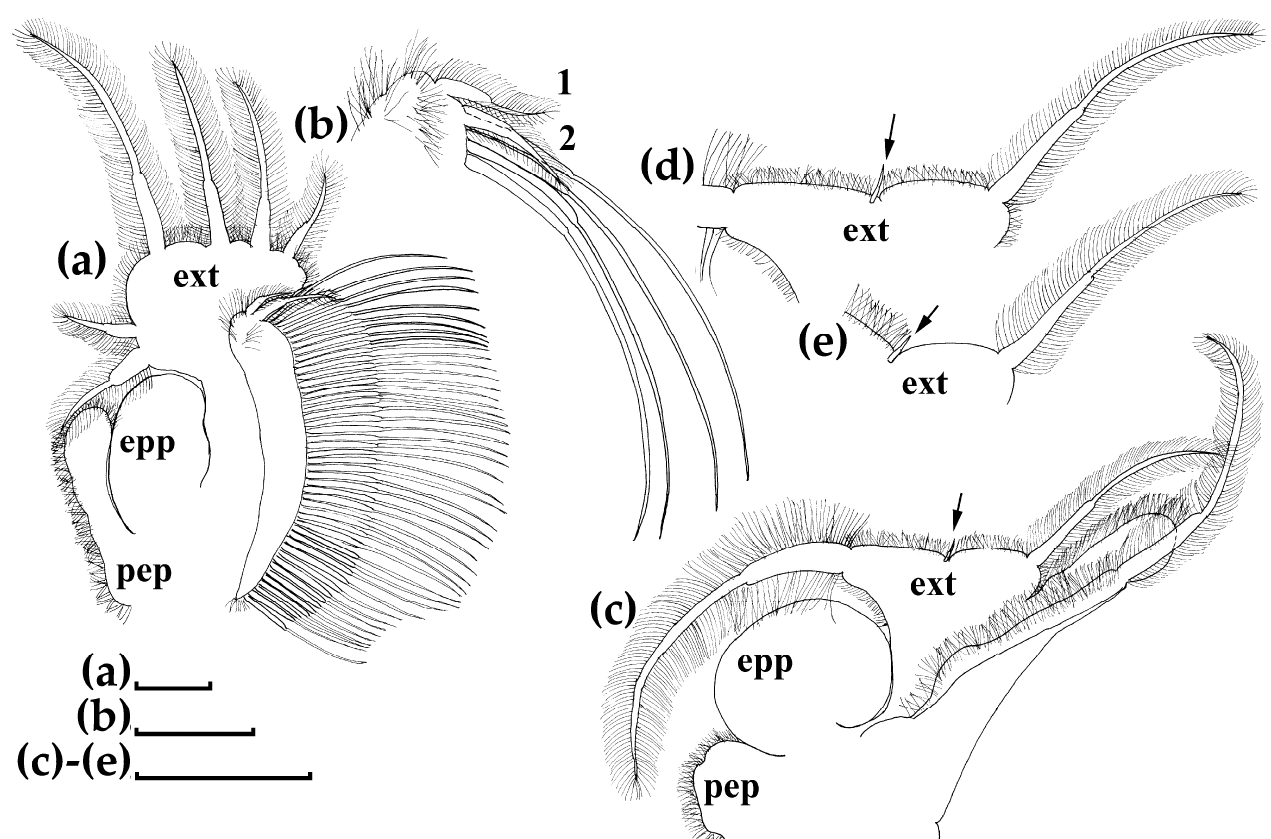
Figure 5. Daphnia arabica sp. nov., a parthenogenetic female from Al Shuwaib Dam, near Al Ain city, United Arab Emirates. ( a ) Thoracic limb IV. ( b ) Fragment of gnathobase of thoracic limb IV. ( c ) Thoracic limb V. ( d , e ) Distal portion of thoracic limb V. All scale bars are 0.1 mm.